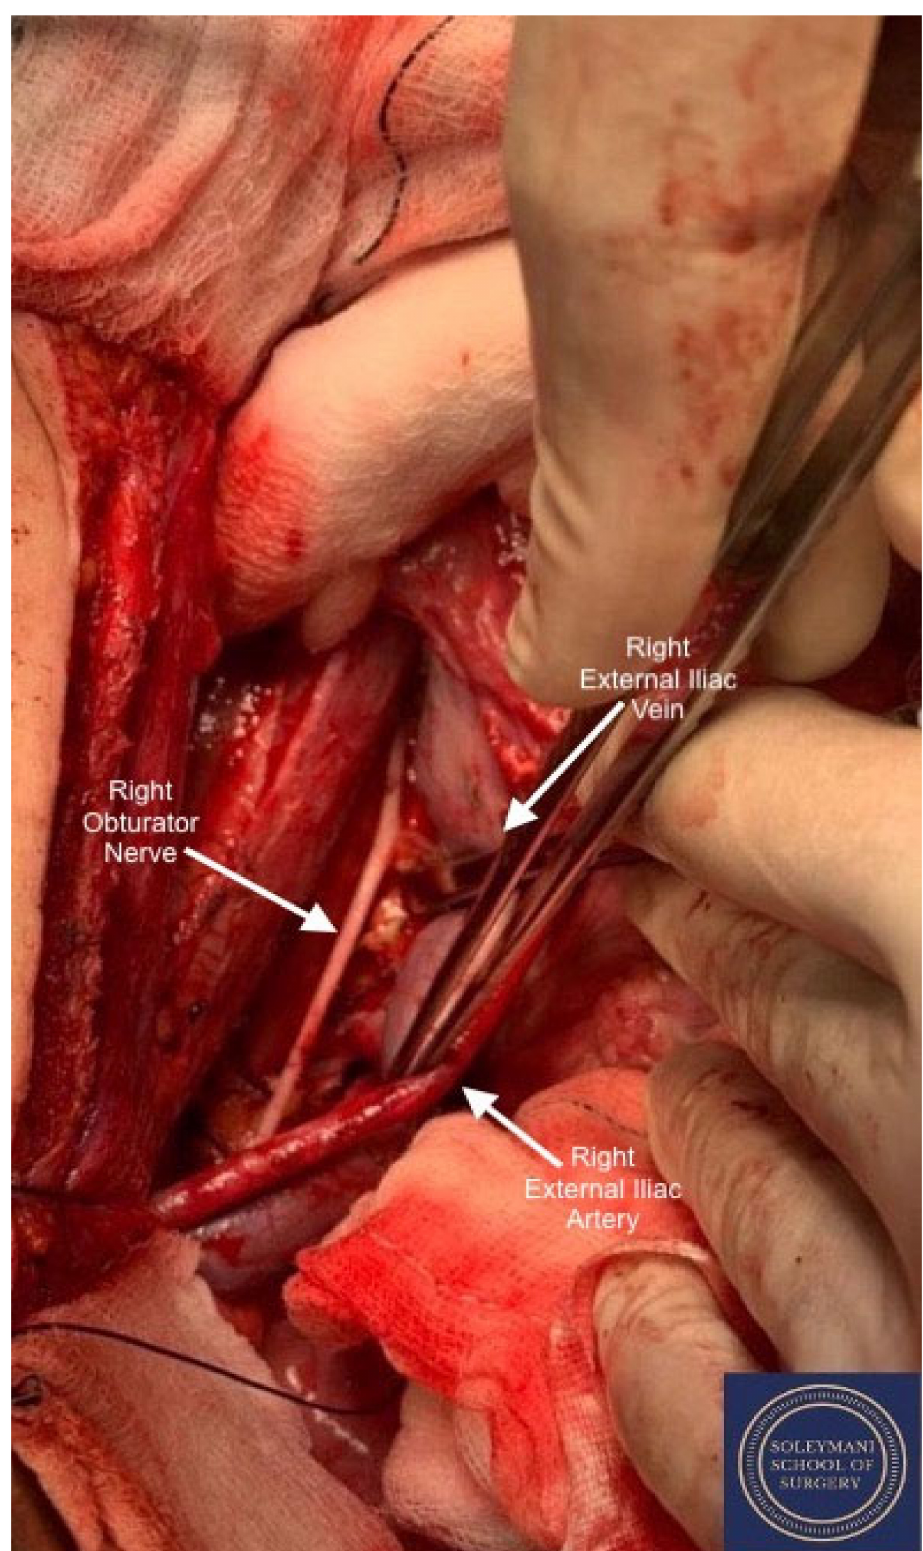
Figure 8. Detail of the right obturator